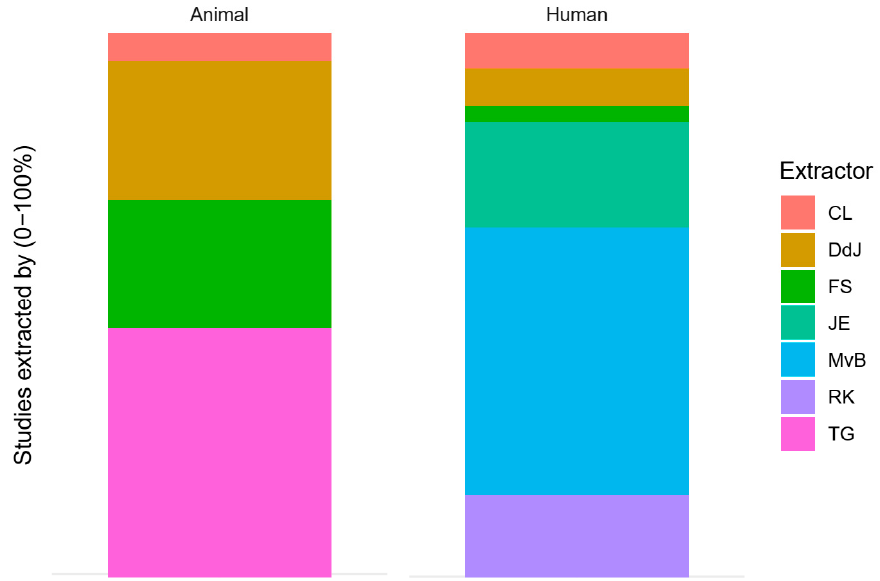
Figure 3. Data extractors. ( a ) Extractors for animal studies; ( b ) extractors for human studies.